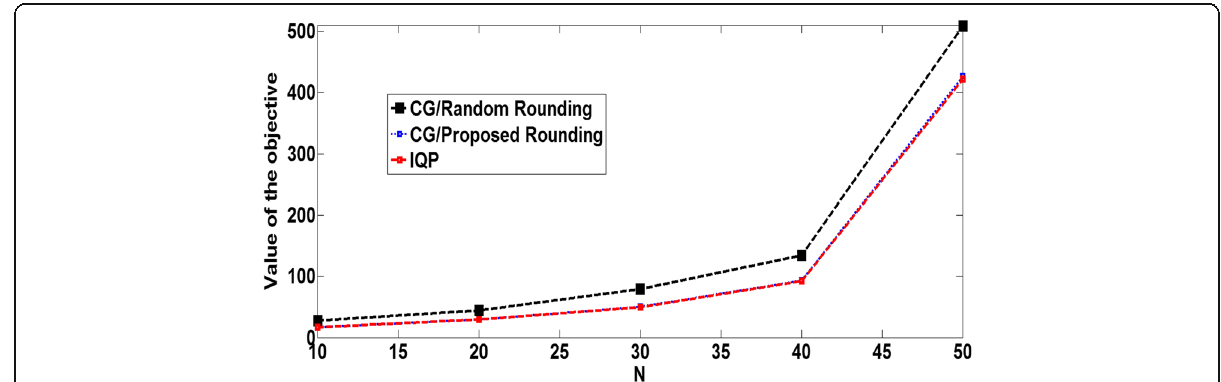
Fig. 12 Comparison of values of the objective functions among IQP, CG/Proposed Rounding and CG/Random Rounding